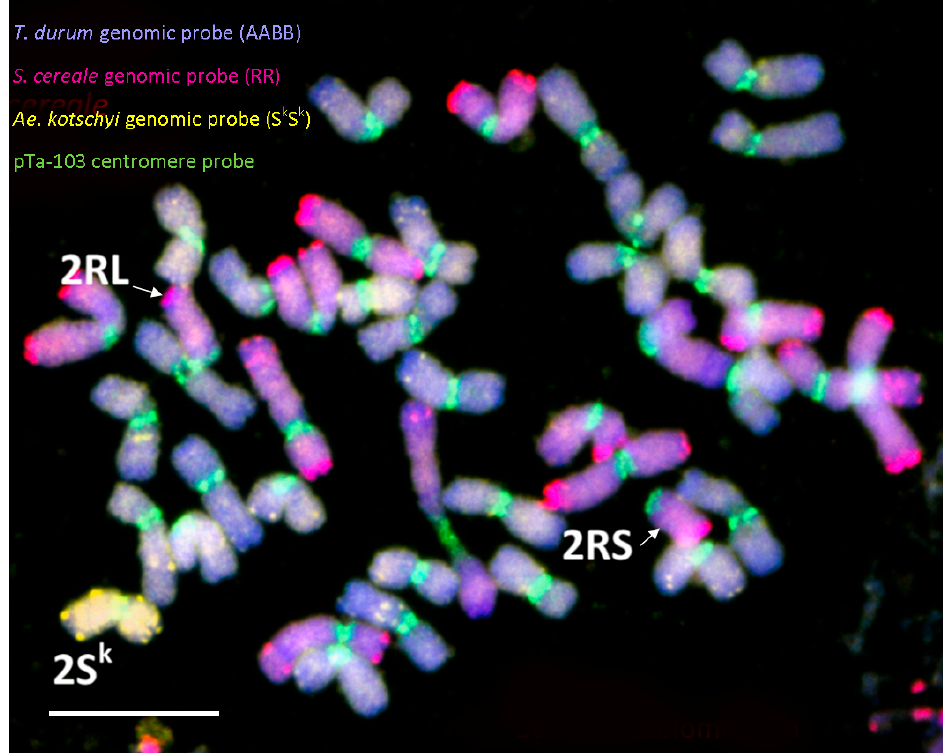
Figure 3. Karyotype of triticale plant carrying 40 + M2RS + M2RL + M2S k chromosomes, examined by genomic/fluorescence in situ hybridization (GISH/FISH). Total genomic DNA of rye (red) and Ae.